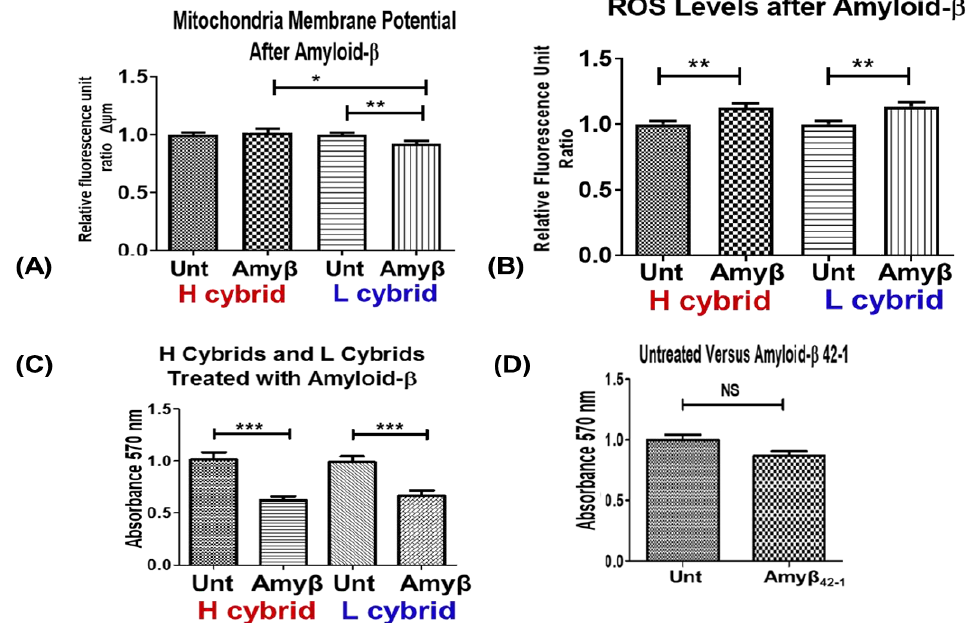
Figure 1. Exploring the difference in responsiveness to Amyloid- β treatment between H (Euro- pean) and L (African) cybrids. ( A ) The effect of Amyloid- β treatment on the mitochondrial mem- brane potential ( ∆ ψ M) of H and L cybrids. H (n = 5) and L (n = 5) cybrids were grown for 24 h in the presence of 20 M Amy β . The JC-1 assay was used to assess ∆ ψ M. ( B ) Amyloid- β treatment had an effect on the reactive oxygen species (ROS) of H (n = 4) and L (n = 5) cybrids. The same conditions as above were used to measure the ROS using H2DCFDA dye. ( C ) The MTT assay was used to determine cellular metabolism. Amy β was applied to H and L cybrids after they had been plated and grown for 24 h. ( D ) Cybrids were exposed to the scrambled Amy β 42-1 peptides (inactive form) and cellular metabolism measured using MTT assay * p -value ≤ 0.05, ** ≤ 0.01, *** ≤ 0.001 and NS: